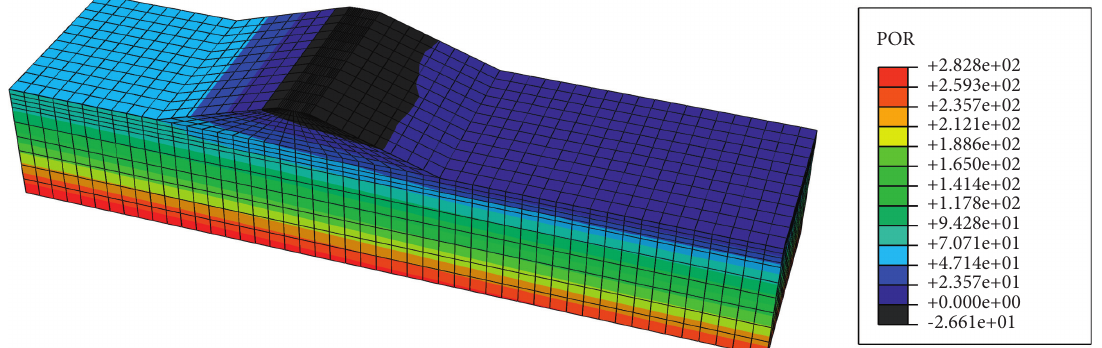
Figure 3: Free surface of the three-dimensional random seepage field.